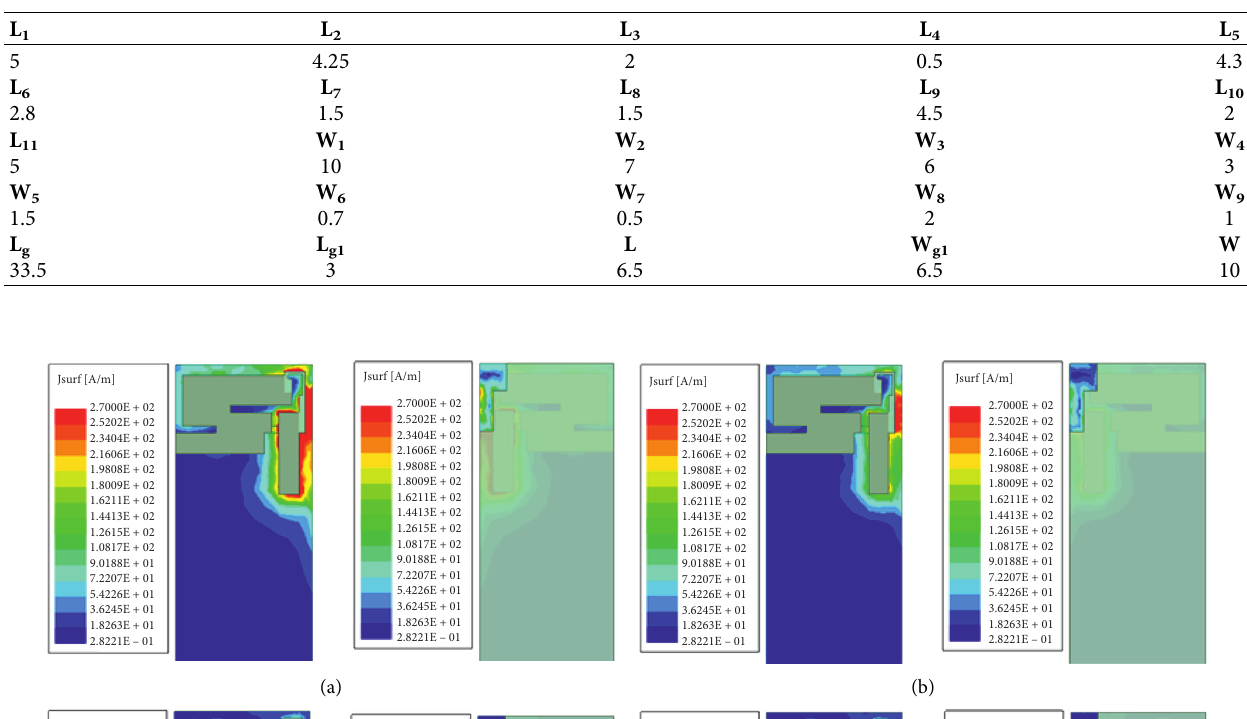
Table 1: Detail dimensions of the planar proposed antenna (unit: mm).